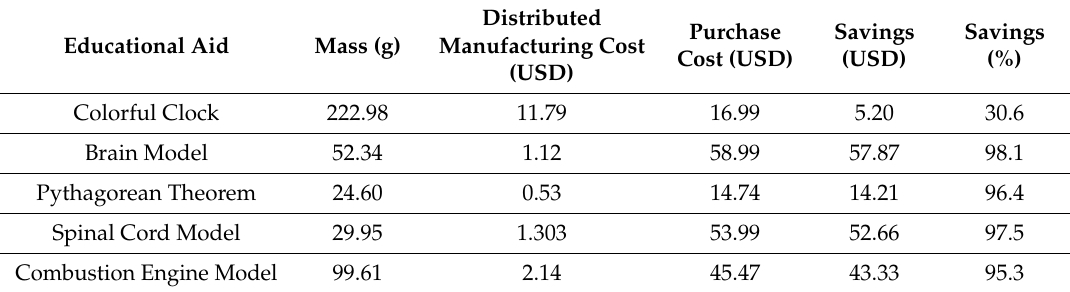
Table 2. Economic comparison of distributed manufacturing and commercial educational aids from measured values of prototypical aids.